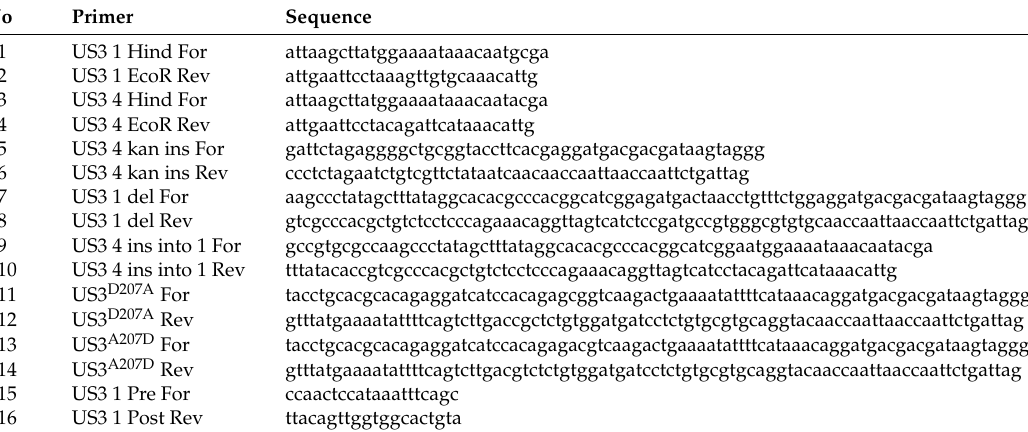
Table 1. Oligonucleotide primers used in this